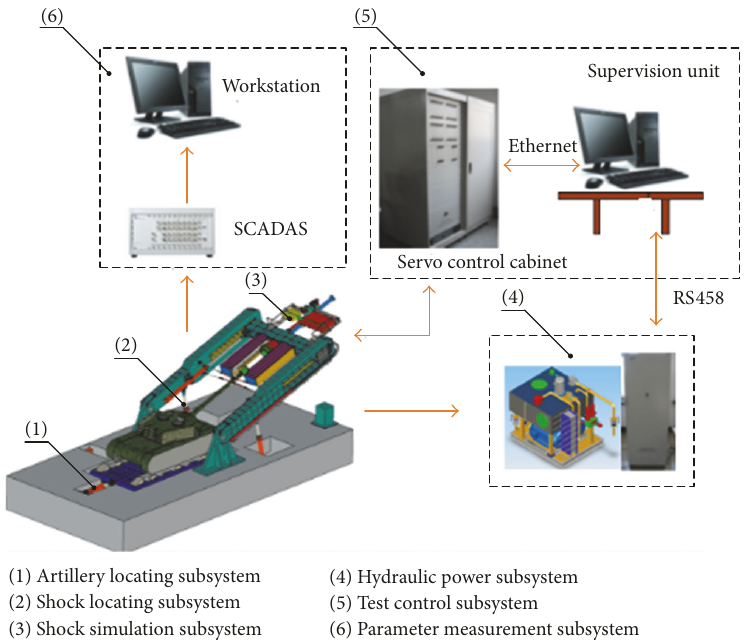
Figure 1: Firing shock simulation test system.